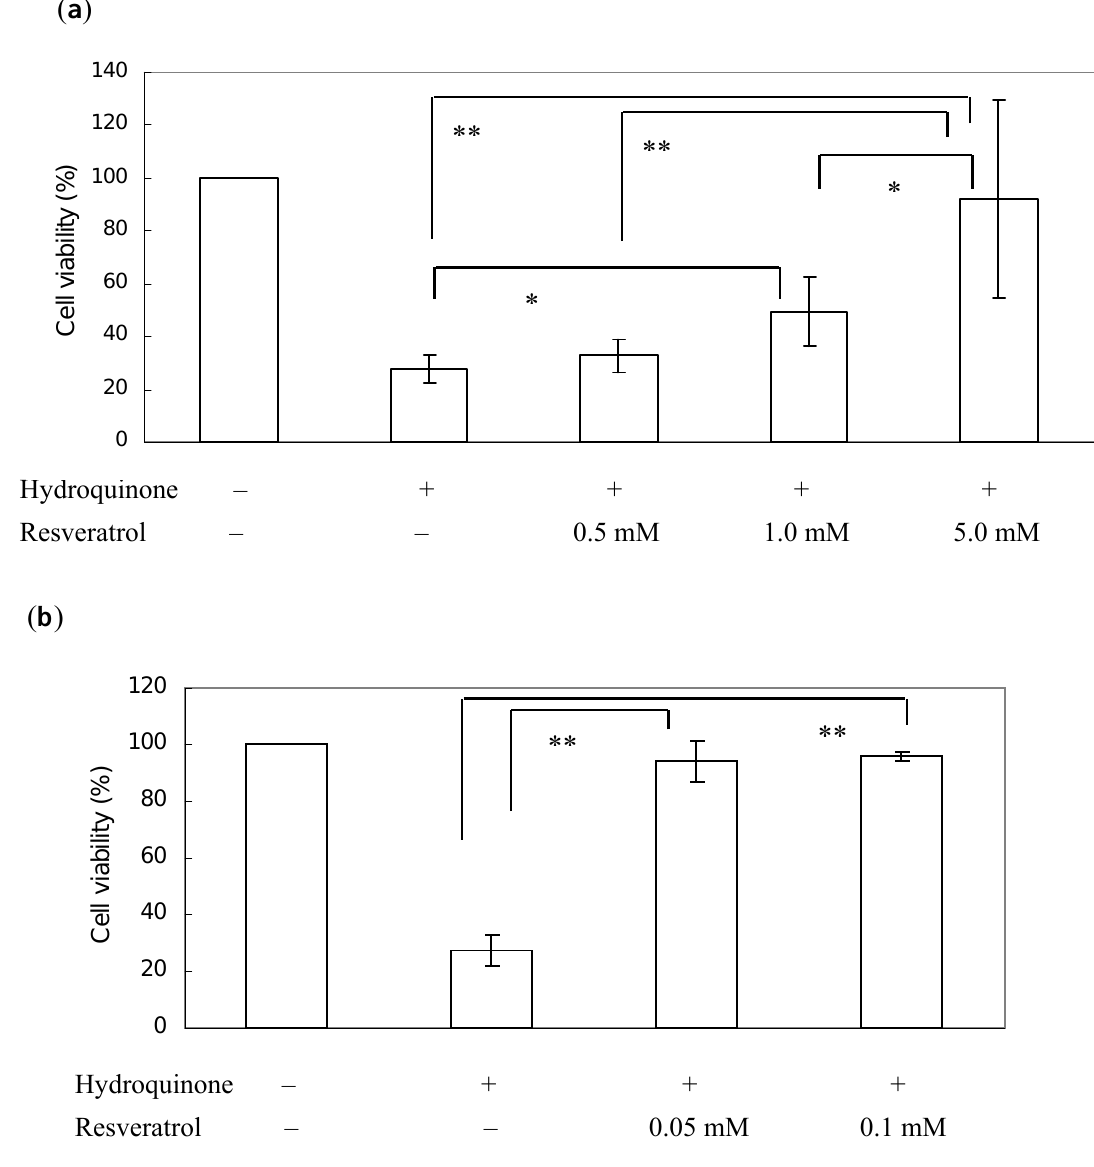
Figure 4 . Effect of resveratrol on hydroquinone-induced hepatocyte toxicity. ( a ) Hydroquinone (0.4 mM) was exposed to the cells for 2 h at 37 °C. Resveratrol was added to the cells 1 h before hydroquinone exposure and was contained throughout the experiments. ( b ) Longer time of resveratrol pretreatment (24 h) at lower